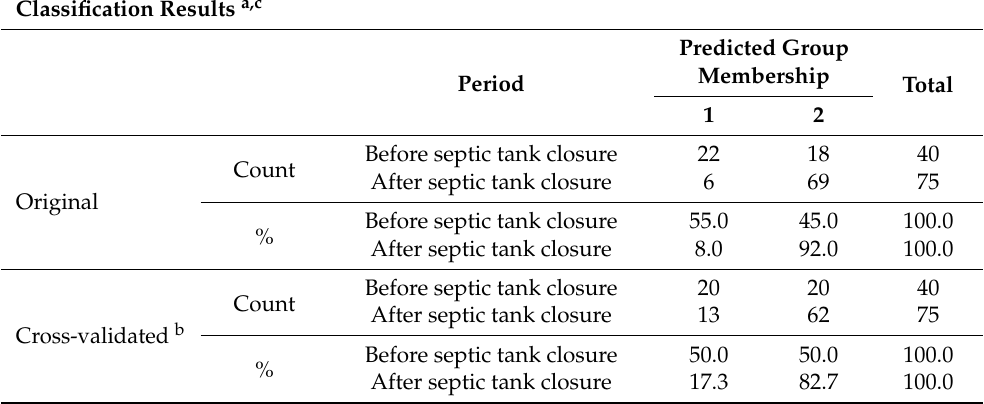
Table 4. Classification results of the discriminant analysis for the period before and after of the septic tank